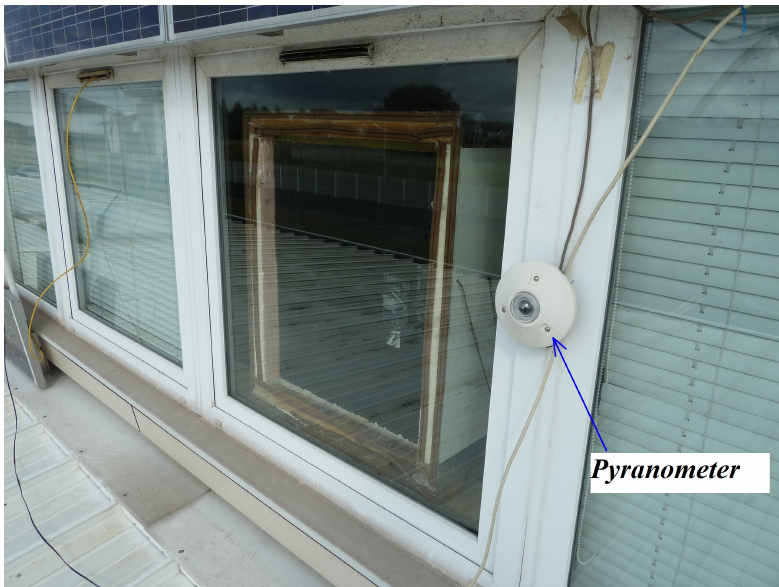
Figure 3. Pyranometer used to measure the global vertical solar